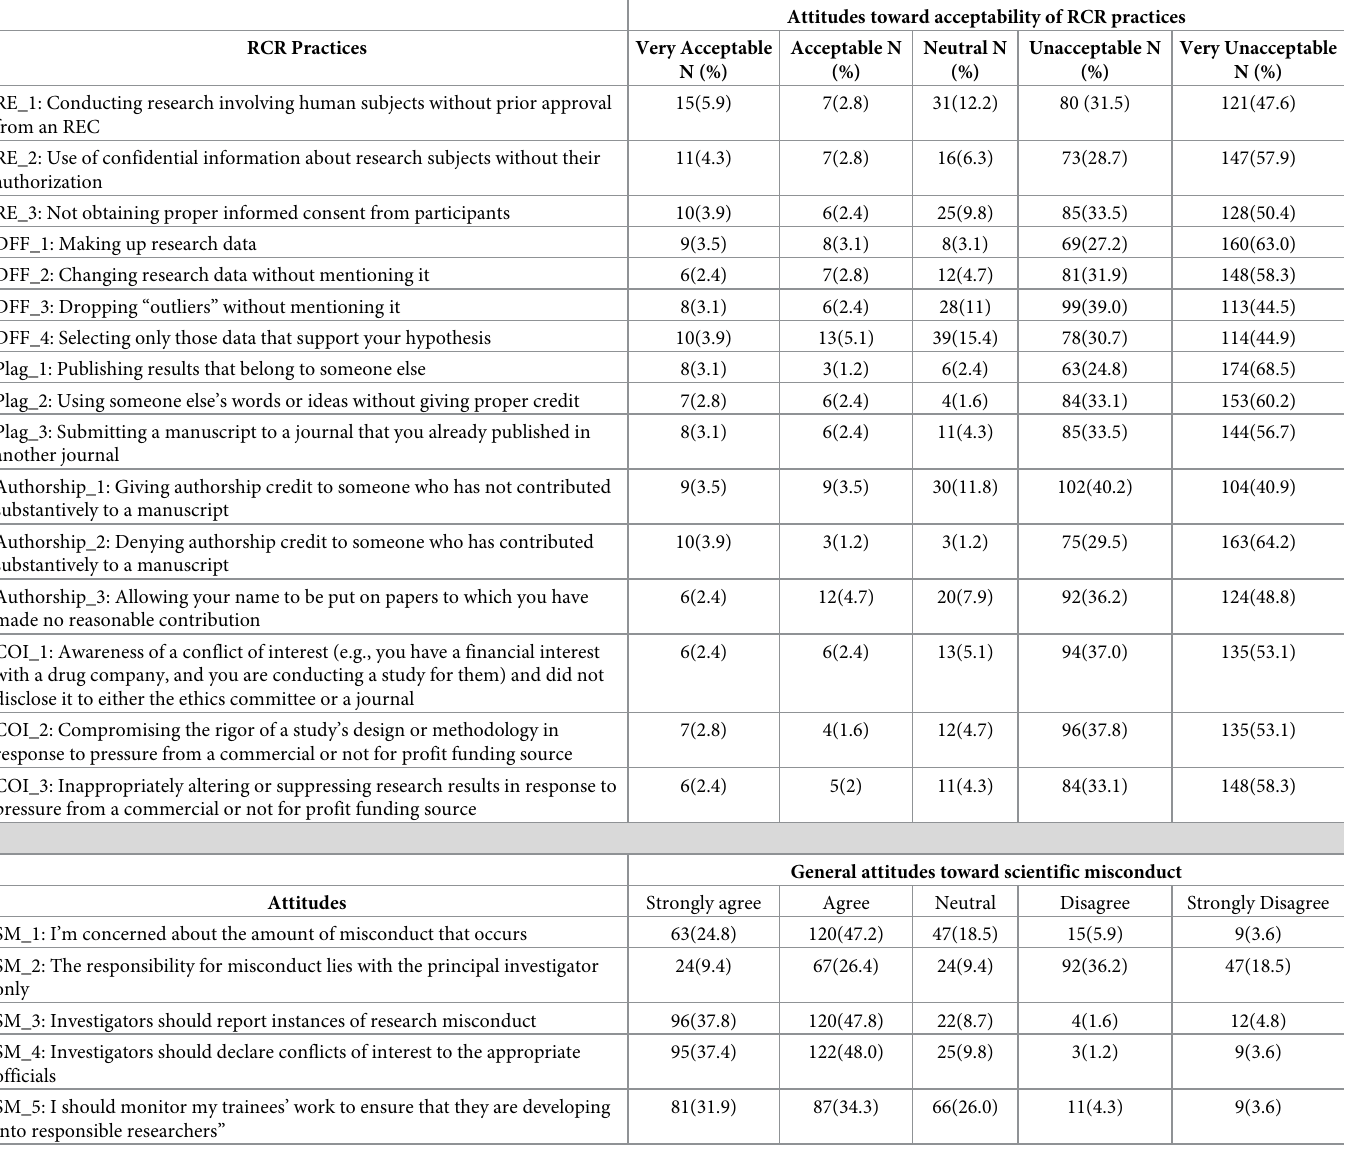
Table 3. Frequency responses to the two “attitude” scales among the study